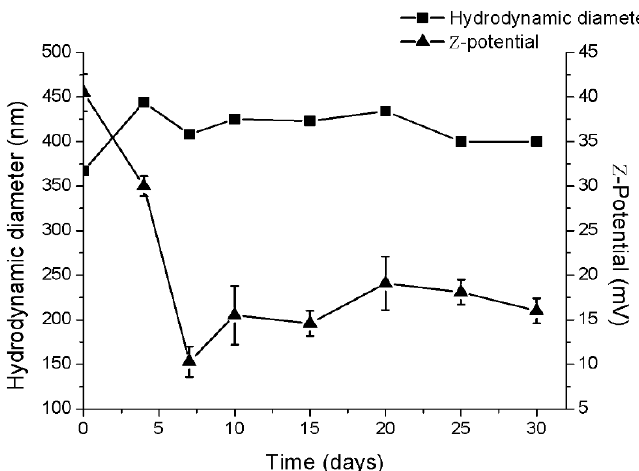
Figure 3. CH-nanoFos colloidal stability: Hydrodynamic diameter and ζ -potential over time.